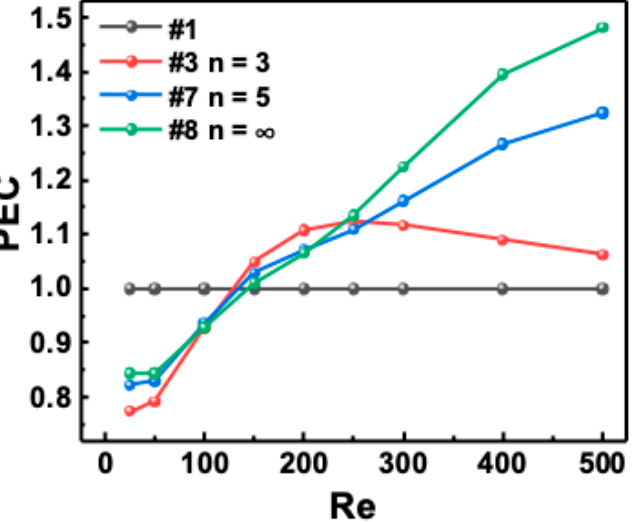
Figure 11. PEC versus Re with different fin smoothness.